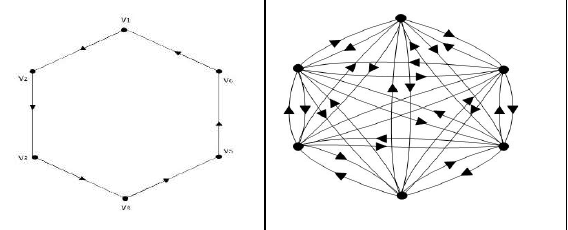
Figure 3 . Cyclic and decentralized network